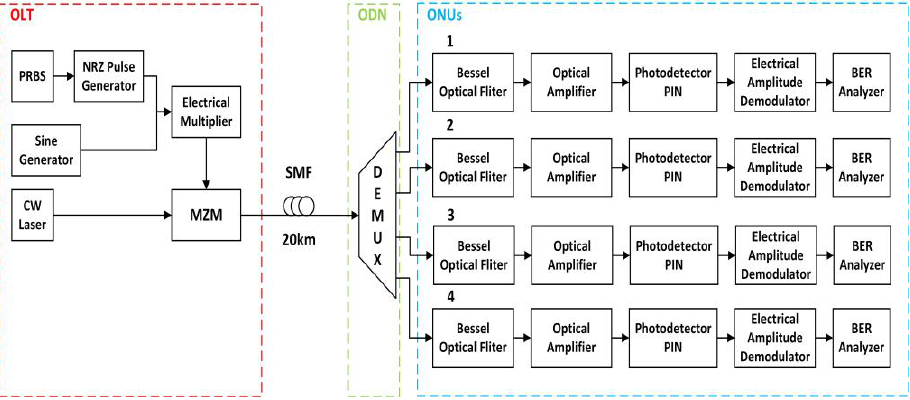
Fig. 1. PON access system using NRZ downstream signals over 6GHz subcarrier.